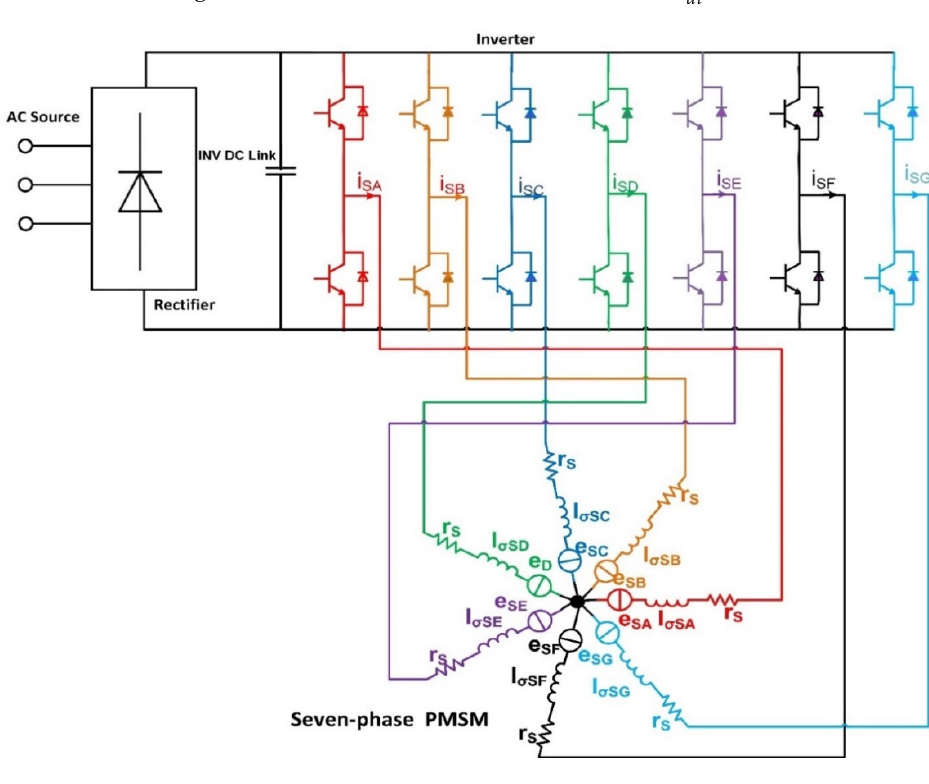
Figure 1. Seven-phase drive topology.